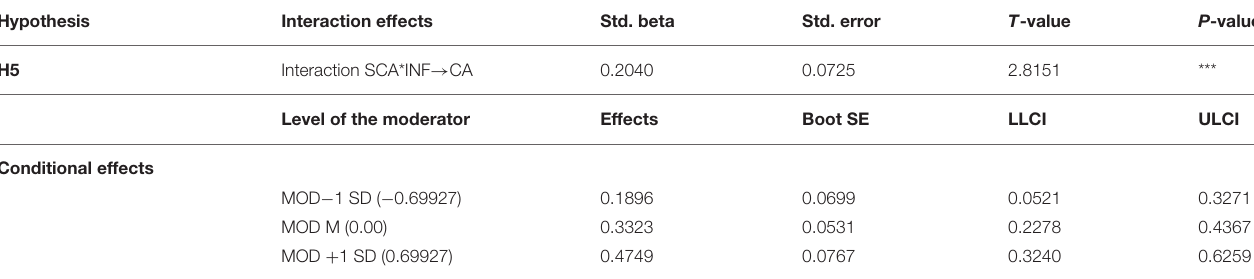
TABLE 4 | Interaction and conditional effects.